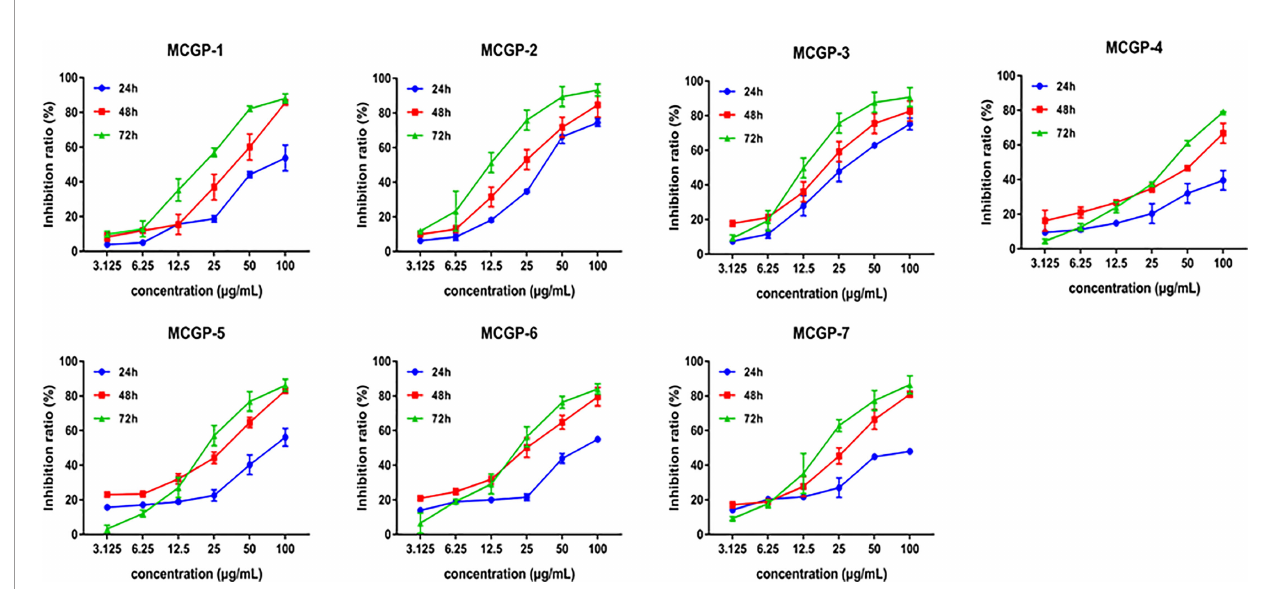
FIGURE 6 | Effects of polysaccharides MCGP-1 – 7 from Panax ginseng on proliferation of HepG2 cells. Monomer components MCGP-1 – 7 are separated and puri fi ed from MCG. After treated HepG2 cells for 24, 48, and 72 h, the inhibition rate of MCGP-1 – 7 in HepG2 cells was measured by SRB. Line graph comparing the inhibition rates. Each value is the average ( ± SEM) of triplicate samples.